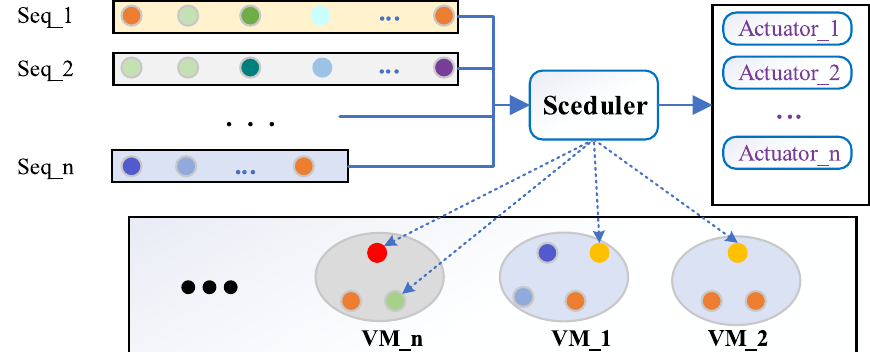
Fig. 3 A brief workflow of service